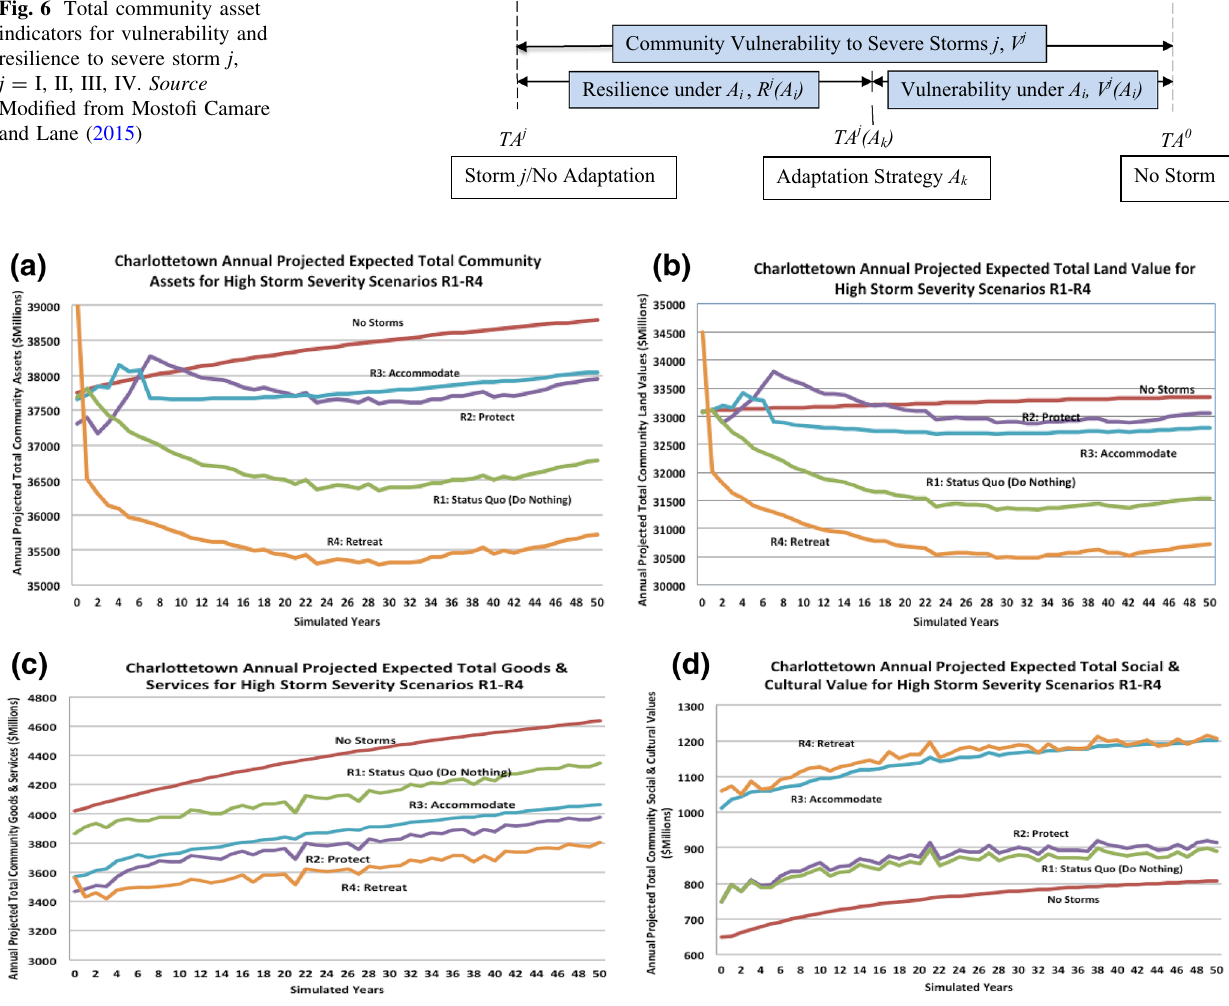
Fig. 7 Charlottetown, Prince Edward Island, High Storm Severity scenarios averages for 10 trials: a Total Community Assets; b Environmental (Land Values); c Economic (Goods and Services); and d Social and Cultural Values (Social Mapping